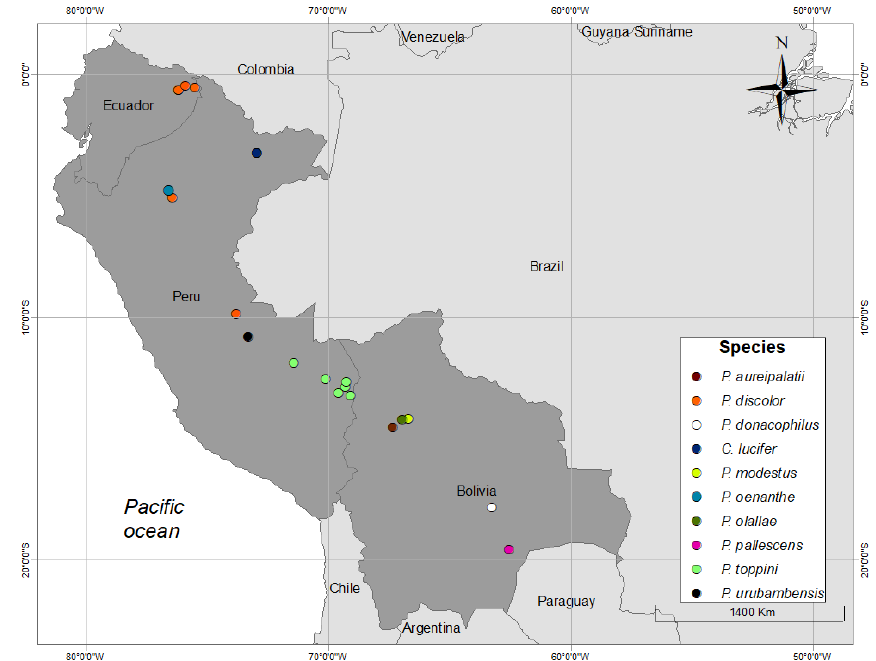
Figure 2. Map showing the 18 recording locations of Plecturocebus and Cheracebus loud calls that were analyzed in this study.